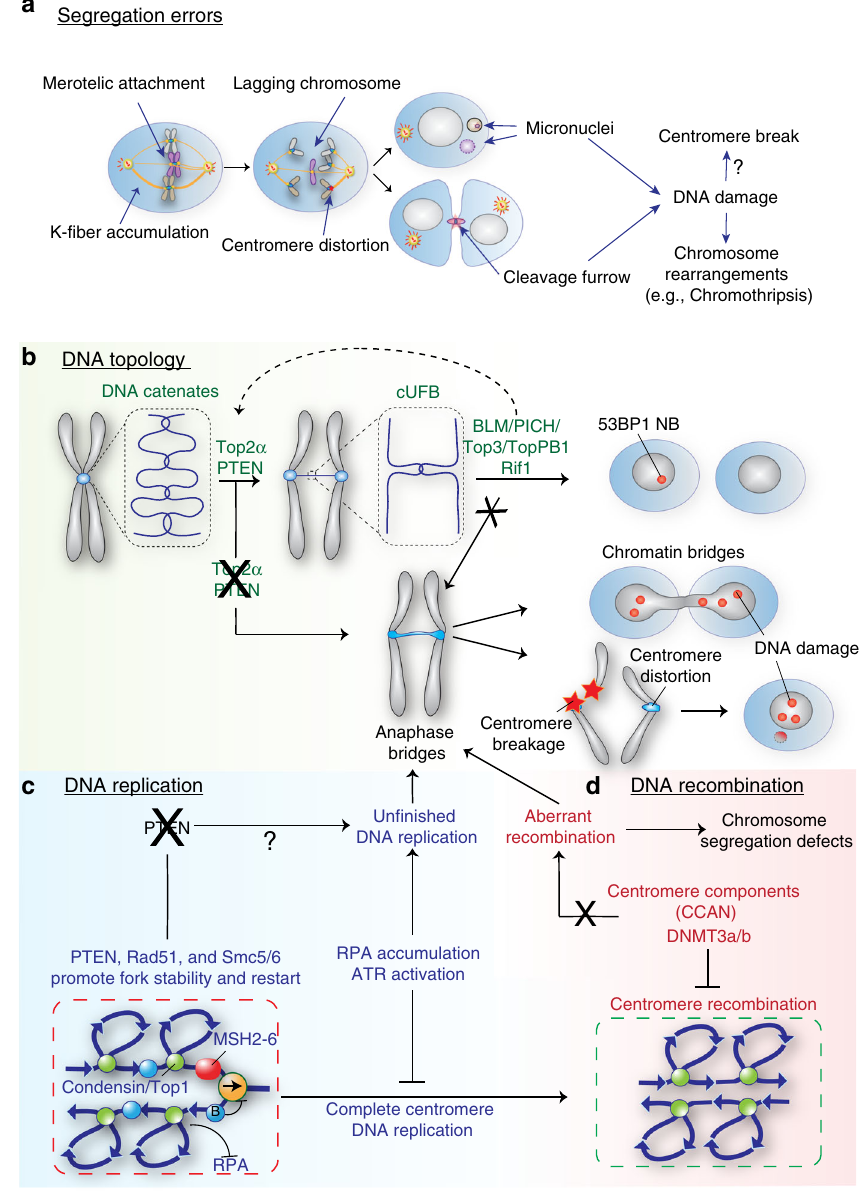
Fig. 2 Origins of centromeric breaks. Schematic of the possible causes that lead to chromosome breaks at centromere. a Segregation errors: merotelic attachment and k- fi ber accumulation are the sources of lagging chromosome formation and centromere distortion in mitosis leading to micronuclei and centromere breaks. b DNA topology: the complex DNA topology enriched in catenanes is normally resolved by topoisomerases prior to completion of sister chromatid separation. Resolution of UFBs is also crucial for maintenance of genome integrity in which a fraction of those results in 53BP1 nuclear bodies (NB) that are repaired in the next cell cycle. Alterations in the centromere decatenation pathway can lead to anaphase bridges and DNA breaks. c , d DNA replication and recombination: due to its highly repetitive sequences a non-canonical pathway of DNA damage and homologous recombination proteins is implicated in the correct completion of centromere replication in order to avoid formation of anaphase bridges, unscheduled recombination and, consequently, segregation errors and